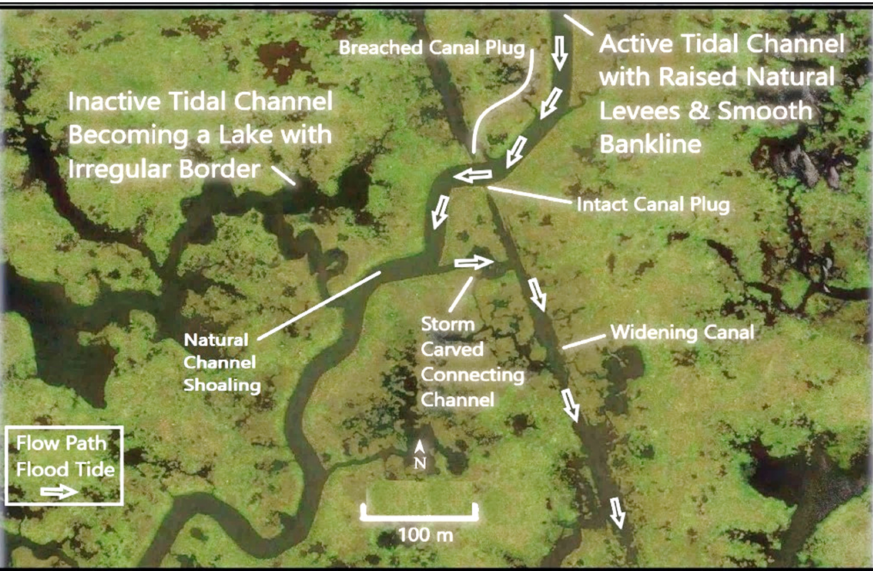
Figure 10. Close-up of western Biloxi Marsh 2 km east of Lake Borgne where a turbid natural tidal channel crosses a canal dredged 15 years earlier. Arrows indicate the flow path on a flood tide. The straight canal captured the discharge of the natural channel when hurricane surge runoff scoured a connecting channel around a canal plug. Abandoned channels/lakes that are cut off from sediment supply appear dark compared to the turbid active tidal